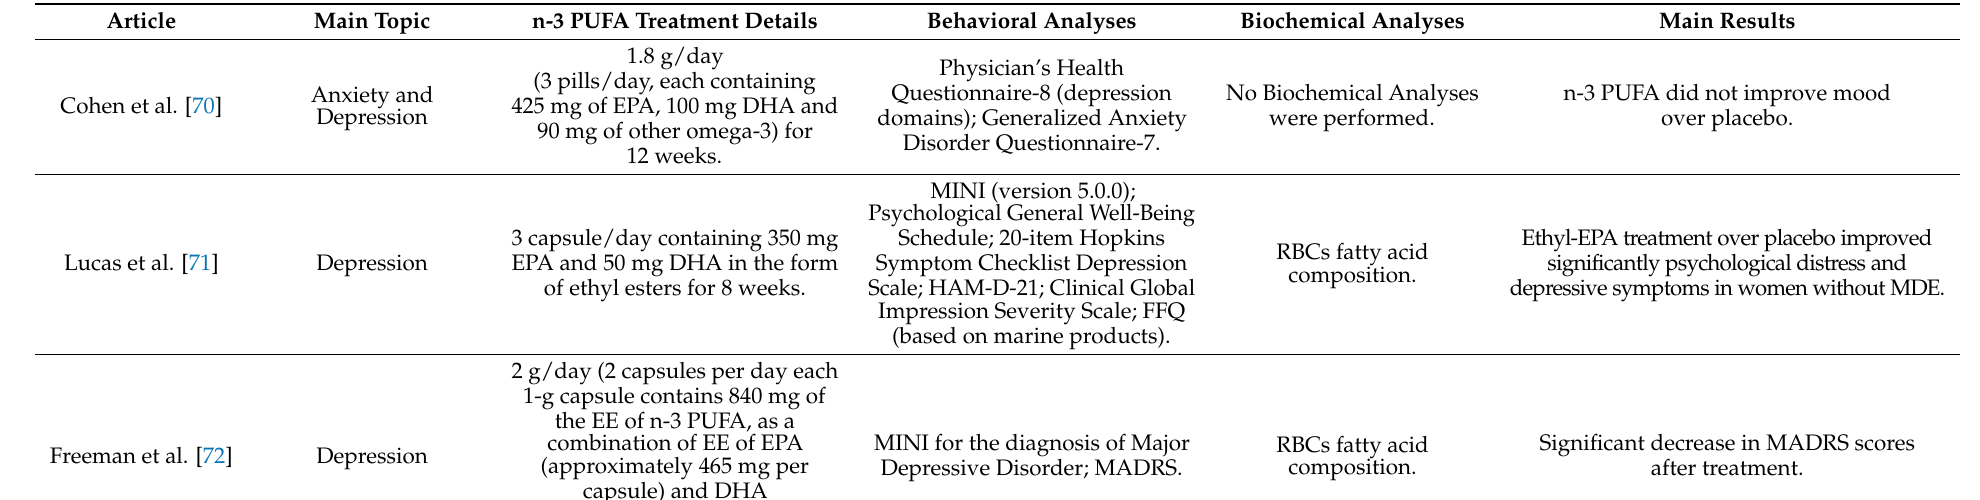
Table 5. Data extracted from human studies: Analyses and main results of rodent